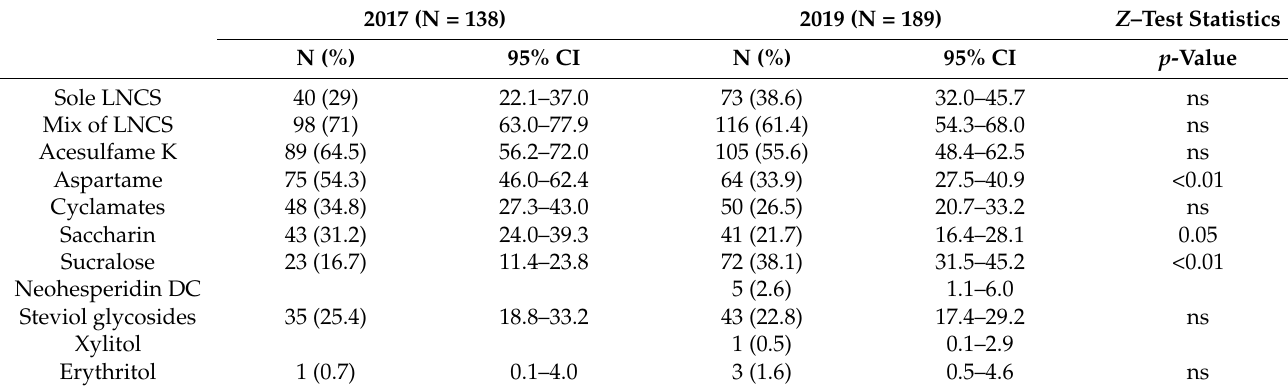
Table 2. Frequency of different types of low and no-calorie sweeteners (LNCS) in beverages with LNCS in 2017 and 2019 (N—number of all LNCS products; CI—confidence interval;